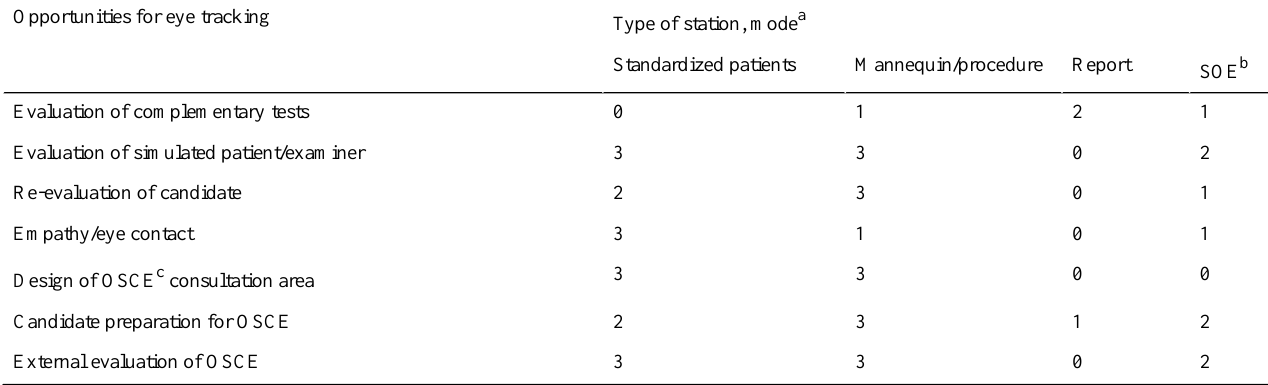
Table 2. Usefulness of portable eye-tracking devices in the OSCE by type of station for 30 station